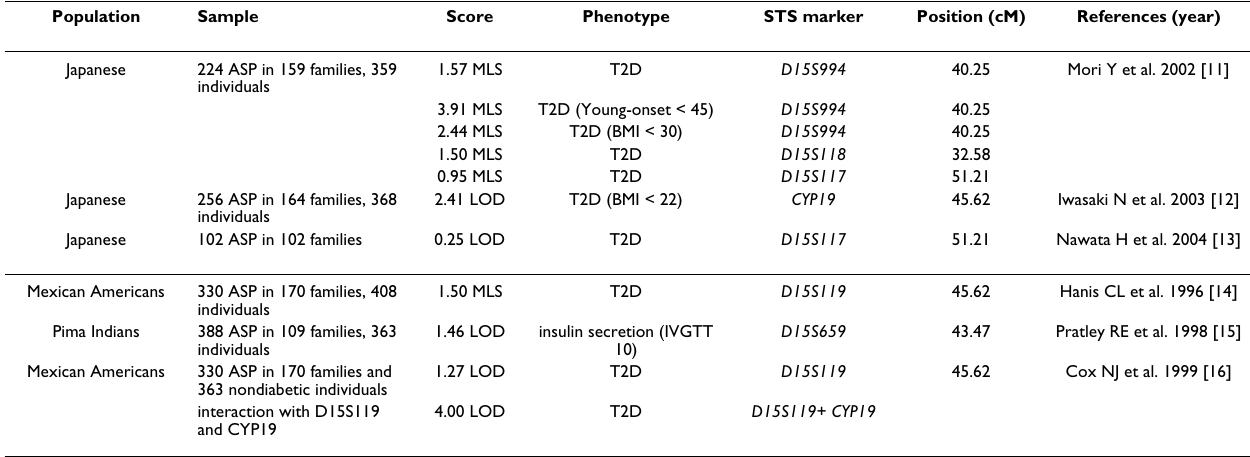
Table 1: Summary of linkage scan on chromosome 15q14-22.1